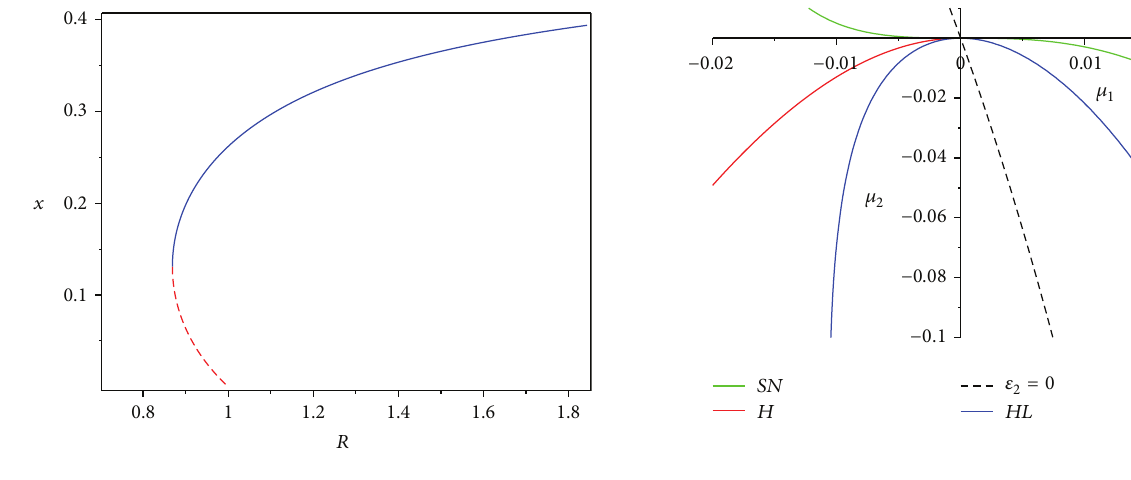
Figure 2: The figure of prey 𝑥 at equilibria versus 𝑅 when 𝑎 = 1.6 , 𝛽 = 2 , 𝑚 = 0.1309 , and ℎ = 0.13 , which displays a backward bifurcation at 𝑅 = 1 .